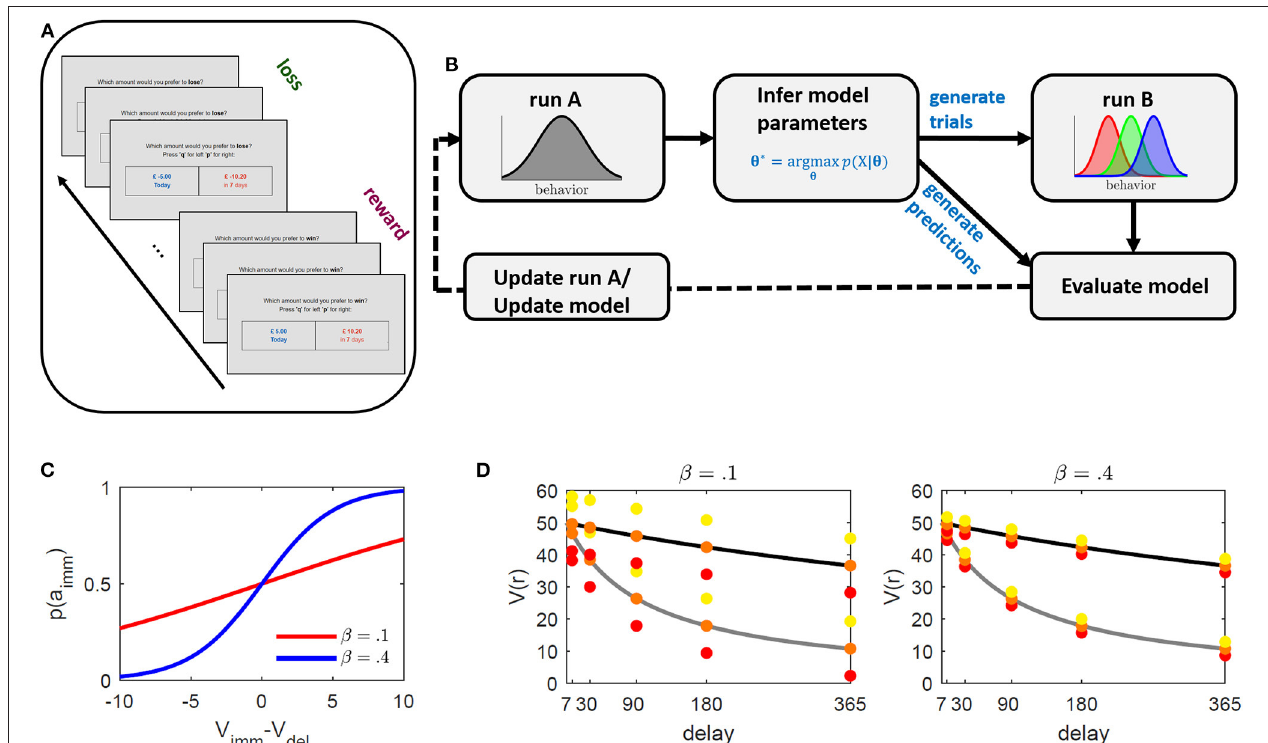
FIGURE 1 | Illustration of the intertemporal choice task (ICT) and proposed paradigm adaptation framework. (A) Schematic illustration of the ICT. Subjects were faced with a series of binary choice trials between an immediate and a delayed outcome. The absolute value of the delayed outcome was always higher. Reward and loss trials were presented within alternating blocks of 40 trials each. (B) Paradigm development framework. Subjects perform an ICT with equal trials across subjects (run A). The task is used to infer subject-level parameters based on a proposed underlying behavioral model. These parameters are used to generate individualized trials designed to elicit relative immediate choice frequencies of 0.3, 0.5, and 0.7 of run B (schematically displayed as red, green, and blue, respectively), and to generate behavioral predictions along with other common discounting models. By comparing observed and predicted behavior in run B, the task underlying model is either updated, or trials of run A are optimized to improve parameter inference. The procedure may be repeated until no further improvement is observed. (C, D) Illustration of method’s operating principle. (C) Immediate choice probability p (a imm ) (cf. Equation 2) as a function of the difference between immediate ( V imm ) and delayed ( V del ) value for β = 0.1 (red), and β = 0.4 (blue). The indifference point where V imm = V del is at 0. If V imm > / < V del , immediate choice probability is below/above 0.5. β regulates the steepness of the curve and thus the sensitivity toward differences in values. Lower β values require larger value differences ( x -axis) to obtain a comparable probability ( y -axis). (D) Discounted value ( y -axis) for different delays ( x -axis) for two hypothetical discount parameter values ( κ = 0.05 in gray and κ = 0.005 in black). The colored dots represent the method’s selected immediate rewards ( = V imm ) at a given delay for the different induced immediate choice probabilities 0.3 (red), 0.5 (orange), and 0.7 (yellow). The distances between immediate values (colored dots) and delayed values (discounting curve) is constant across all delays to ensure equally induced probabilities across delays (see graph (C) ). This also indicates that for subjects with different κ ’s, the reward and value ratios will vary. The left graph depicts selected rewards for a hypothetical β = 0.1 and the right graph for β = 0.4. While β regulates discounted value of the delayed reward V del , κ regulates the distance of the selected immediate reward around V del with higher β resulting in smaller differences, making the differentiation between the two more difficult (that is, requiring higher